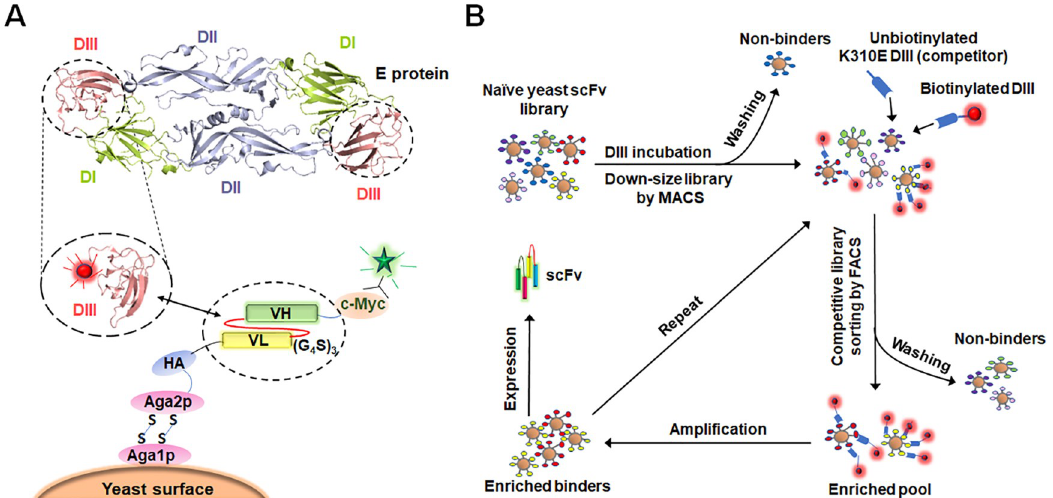
Fig 1. Yeast display-based bio-panning for the isolation of DENV DIII-specific antibodies. (A) The DENV E protein is consist of DI, DII and DIII, which are shown in green, cyan, and light pink, respectively. The scFv was displayed as an Aga2p (rose red) fusion protein on the surface of yeast. Antibody expression can be detected by using fluorescent anti-c-Myc antibody (green), and binding of the scFv to the biotinylated DIII can be detected using PE-conjugated streptavidin (red). HA, hemagglutinin; VL, variable light chain; VH, variable heavy chain; (G 4 S) 3 , (Gly 4 Ser) 3 -flexible peptide linker. (B) Schematic of the scFv panning process. The biotinylated DIII, shown with a fluorescent tag colored in red, was used as the antigen for bio-panning, and ten times concentration of unbiotinylated DIII K310E mutant was used as the competitor. MACS and FACS-based sorting strategies were used to isolate high affinity binders from the yeast-displayed antibody library.